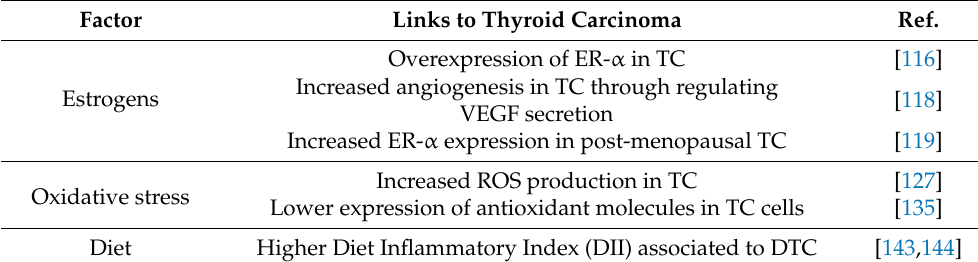
Table 1. Cont. Factor Links to Thyroid Carcinoma Ref. Overexpression of ER- α in TC Increased angiogenesis in TC through regulating Estrogens VEGF secretion Increased ER- α expression in post-menopausal TC Increased ROS production in TC Oxidative stress Lower expression of antioxidant molecules in TC cells Diet Higher Diet Inflammatory Index (DII) associated to